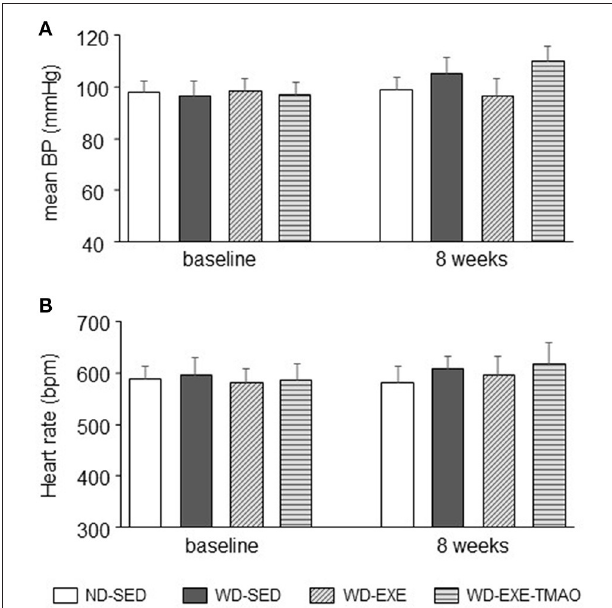
FIGURE 6 | Effects of voluntary exercise and TMAO supplementation on mean blood pressure and heart rate in mice fed a western diet (WD). No significant differences in mean blood pressure (BP), (A) and heart rate (B) were observed across the four groups at baseline and 8 weeks. Sedentary: SED; voluntary exercise: EXE; TMAO: trimethylamine N-oxide. Data are presented as mean ± SE ( n = 10 for each